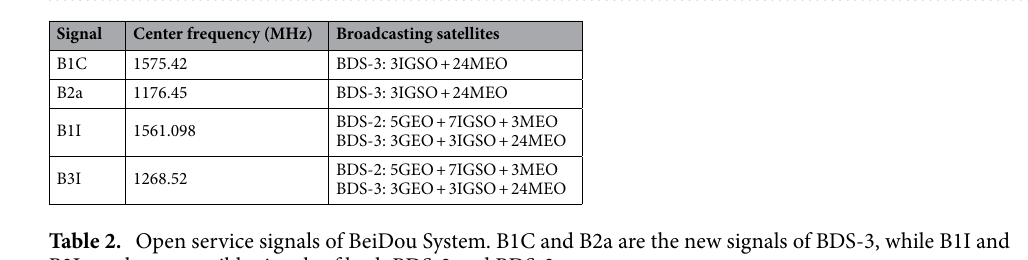
Figure 1. Tracks of sub-satellite points for in-orbit operational BeiDou satellites. The red and blue lines denote BDS-2 and BDS-3 satellites, respectively.